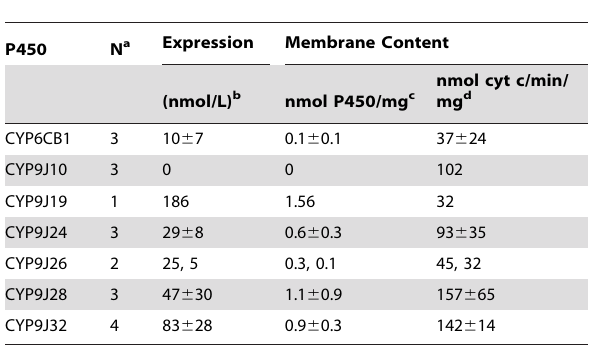
(Table 4). The apparent K M measurements for permethrin ranged from 2.3 6 1.1 m M (CYP9J32) to 4.2 6 0.9 m M (CYP9J26) and for